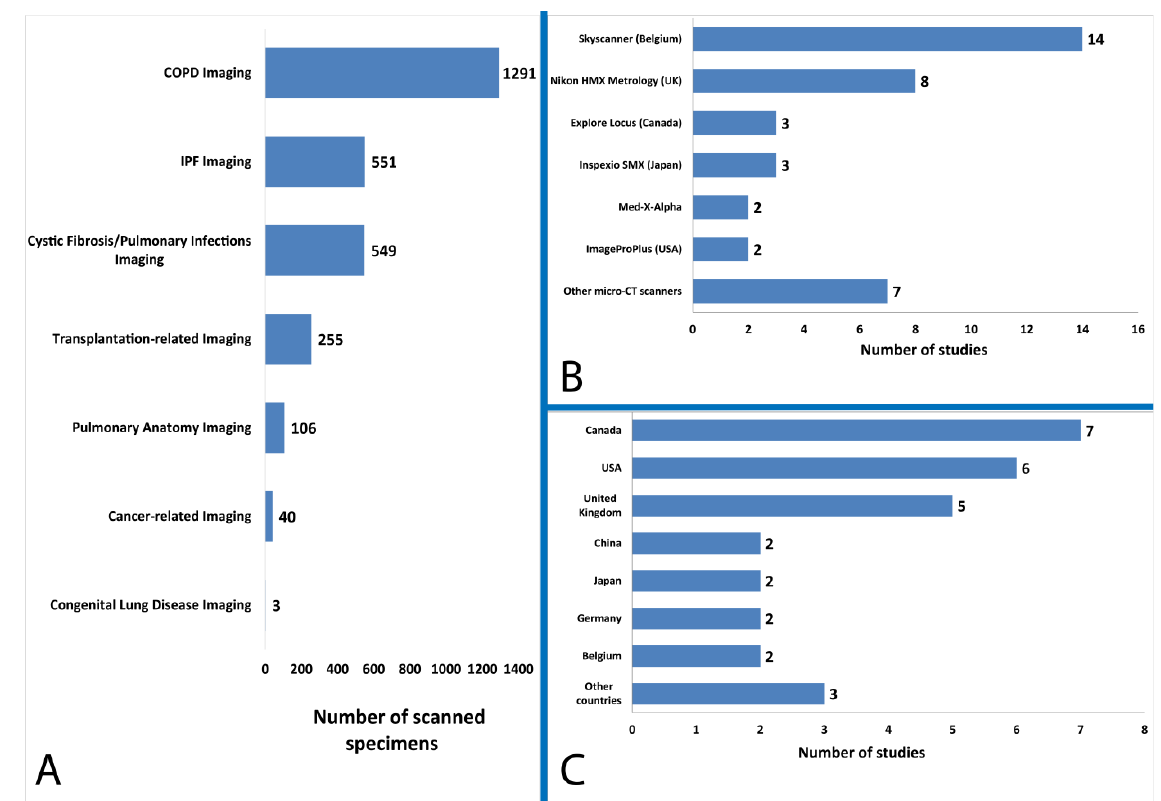
Figure 2. Included study characteristics. ( A ) Number of scanned specimens according to the topic assessed, ( B ) Micro- computed tomography scanners utilized, and ( C ) Geographical distribution of included studies.